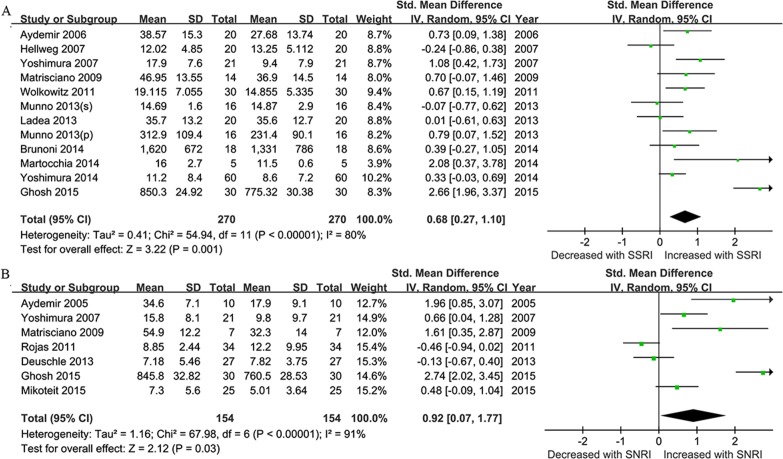
Sample- Stratified Subgroup Meta-Analyses.Forest plots showing the summary effect sizes for levels of BDNF pre- and post- antidepressant drugs treatment (less than 12 week) in serum (A) or plasma(B).